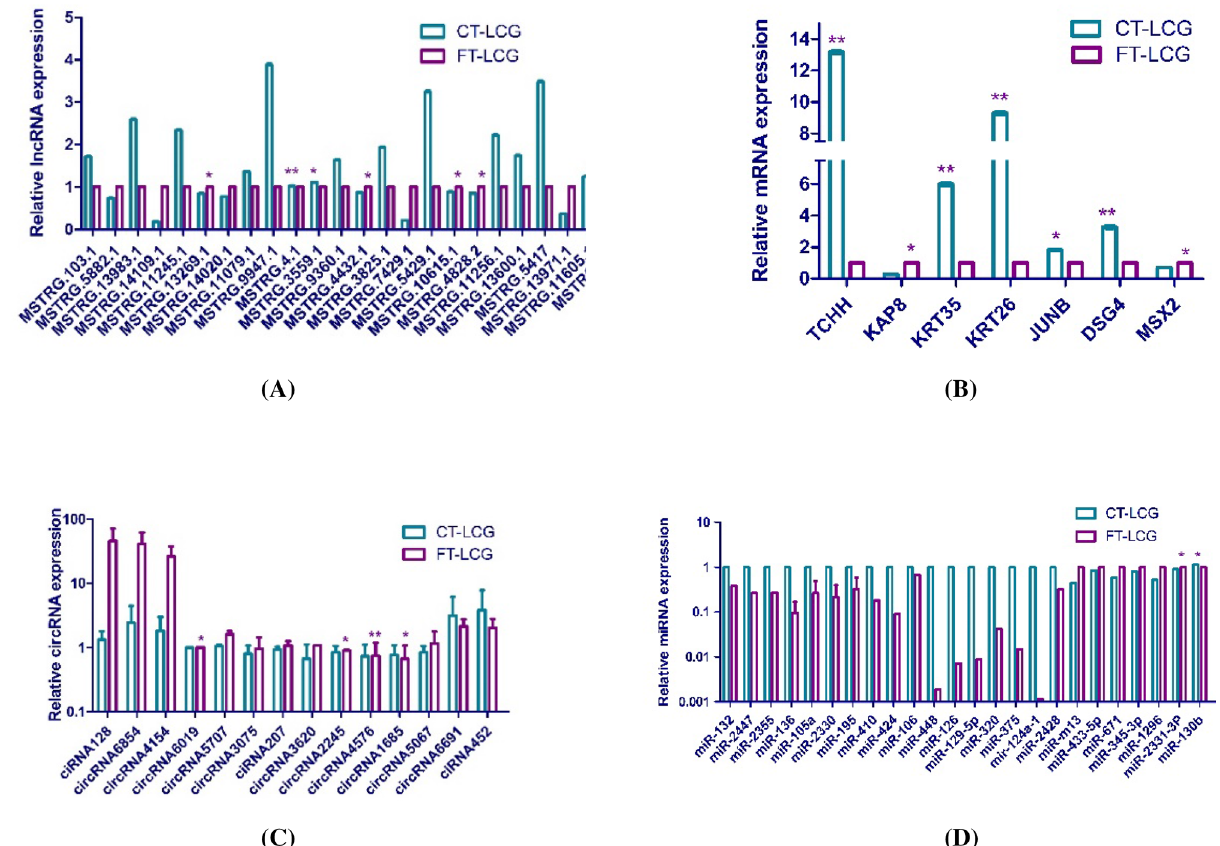
Figure 4. QRT-PCR verification of DElncRNAs, mRNAs, circRNAs and miRNAs between CT-LCG and FT-LCG. ( A ) DElncRNAs between CT-LCG and FT-LCG validated by qRT-PCR. ( B ) DEmRNAs between CT-LCG and FT-LCG validated by qRT-PCR. ( C ) DEcircRNAs between CT-LCG and FT-LCG validated by qRT-PCR. ( D ) DEmiRNAs between CT-LCG and FT-LCG validated by qRT-PCR.